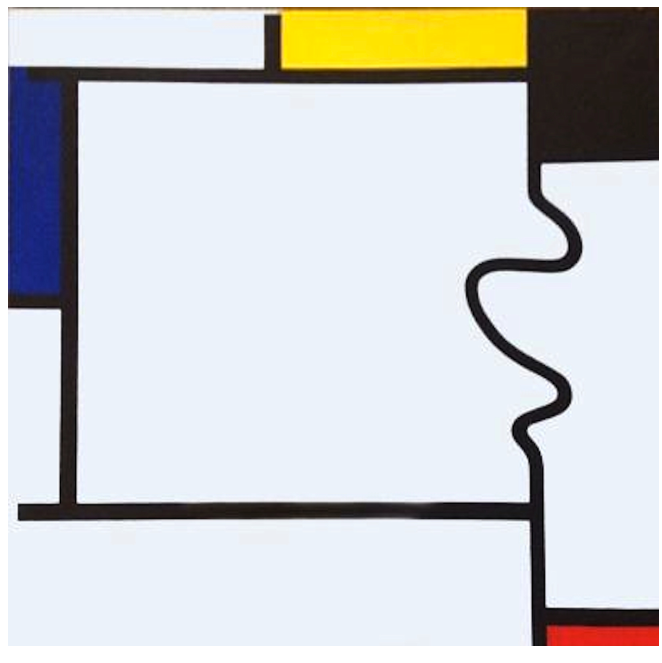
Figure 4: Rob Scholte, Mondriaan